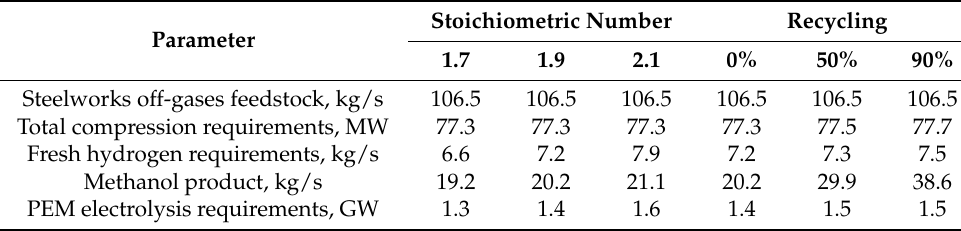
Table A6. Key results of the MeOH case.